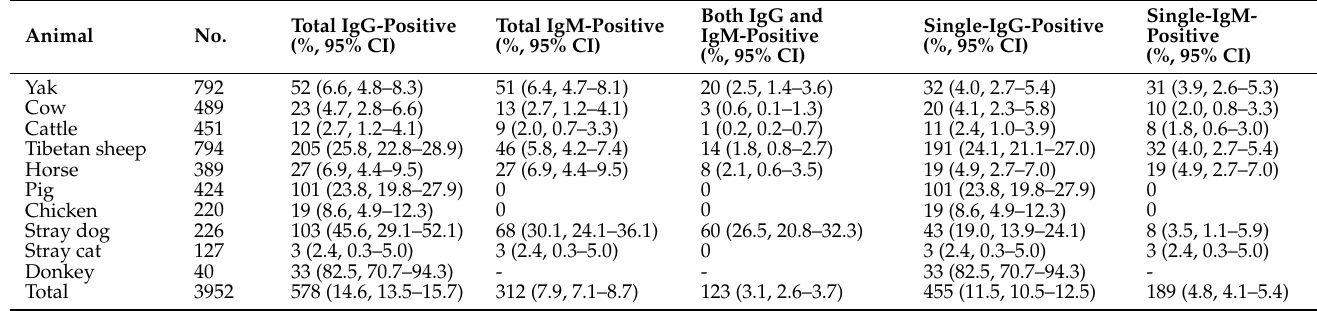
Table 2. Seropositive rates of Anaplasma IgG and IgM antibodies in animals in the QTPA.